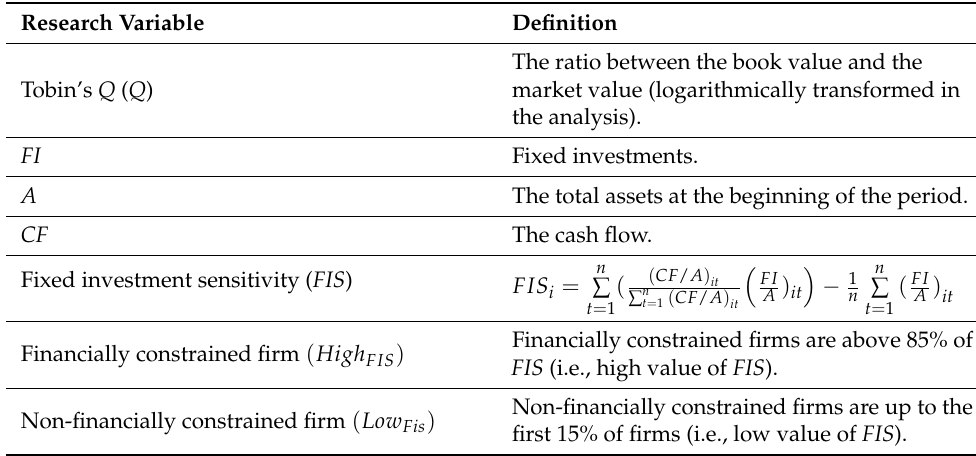
Table 1. Summary of research